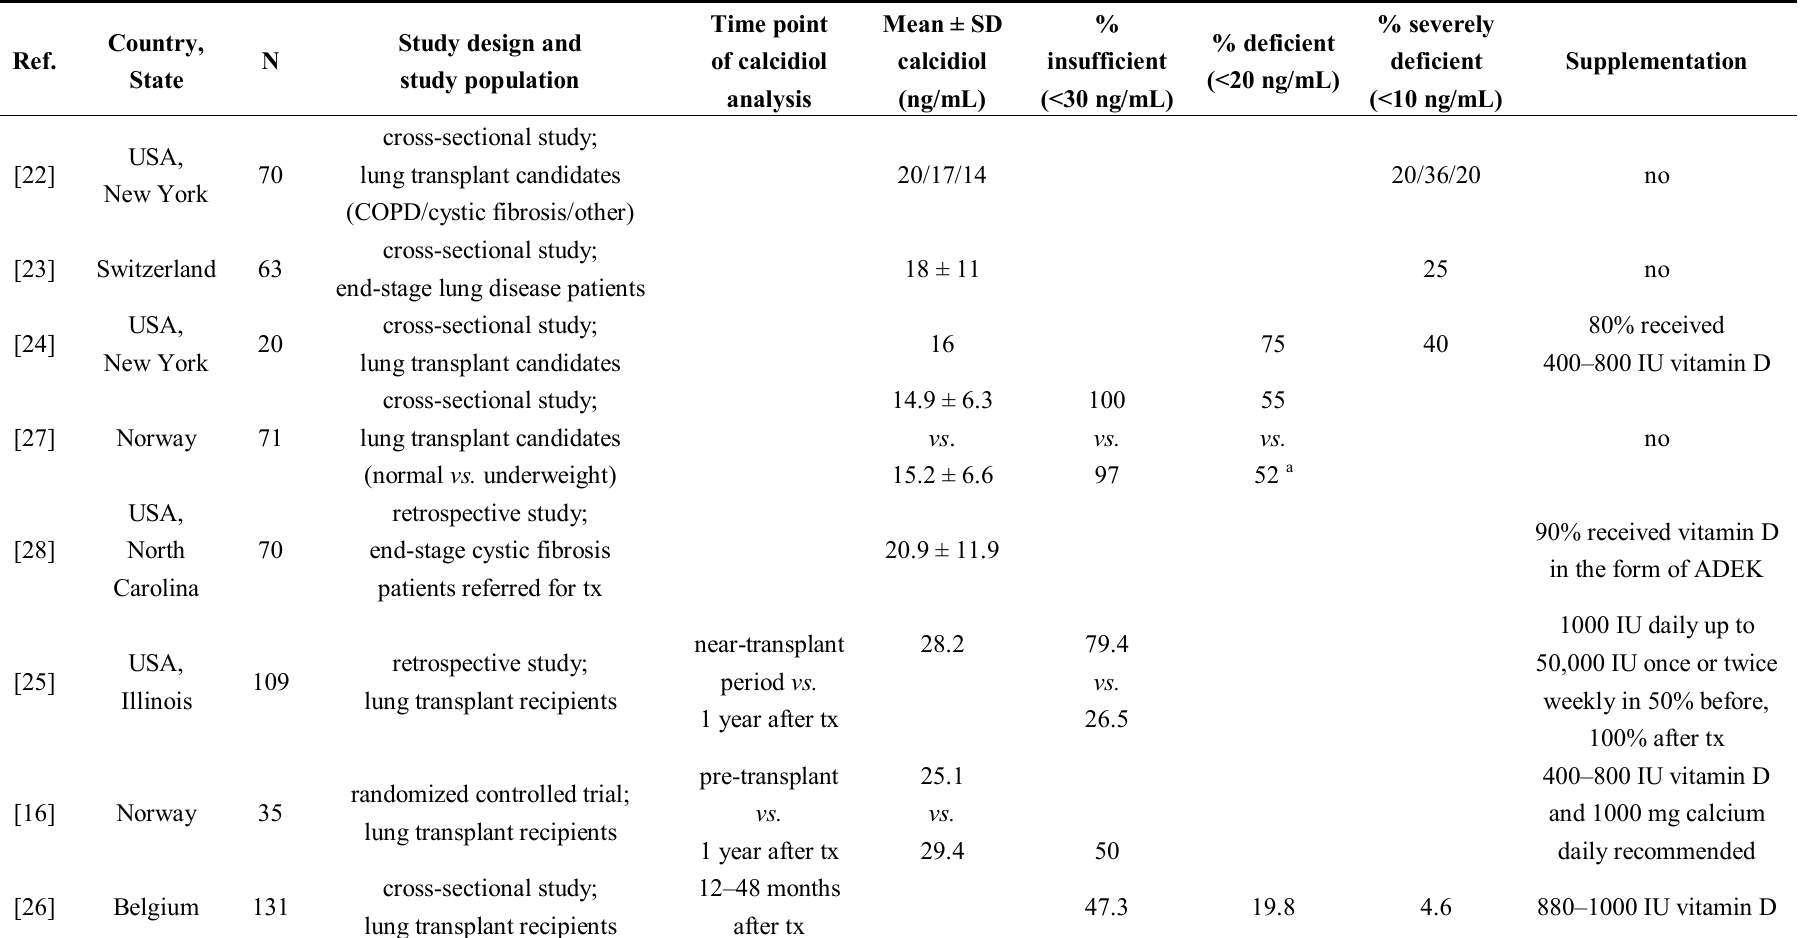
Table 2. Vitamin D status in end-stage pulmonary disease and lung transplant patients.